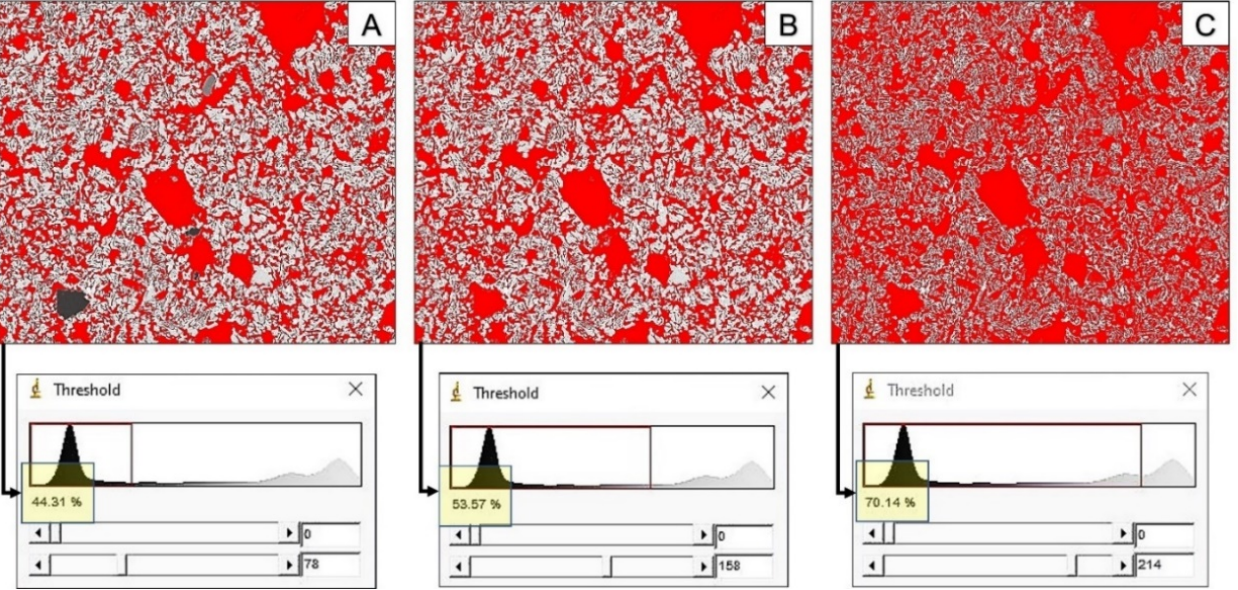
Figure A2. Greyscale Analysis (% red region) to find out phase composition & porosity of image. Red region ( A ) covering pores, ( B ) covering pores as well as gangue and ( C ) covering pores, gangue and iron oxide.